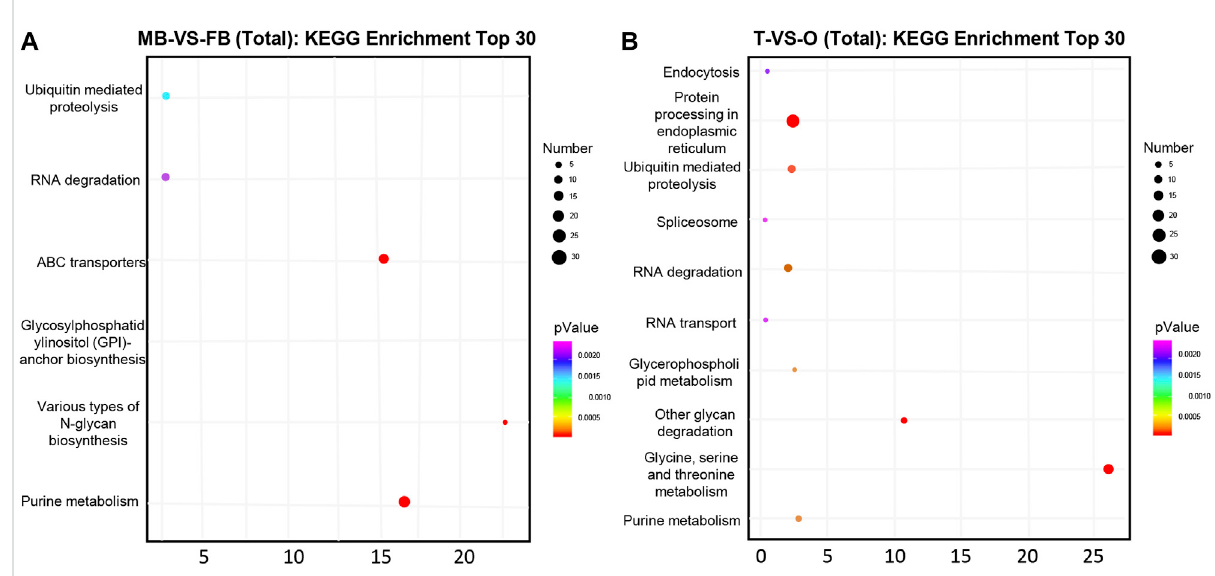
FIGURE 2 Top30signi fi cantlyenrichedKEGGpathwaysofputativetargetgenesbetweenthefemaleandmale macrobrachiumrosenbergii inthebrain (A) andgonad (B). Signi fi cantenrichmentoftheKEGGpathway( p < 0.05).Thecolorrepresentsthesizeofthe p -valueandthepointrepresentspathway. The redder the color, the smaller the p -value, the larger the number of points, and the more enriched genes. MB: male brain; FB: female brain; T: testis; O: